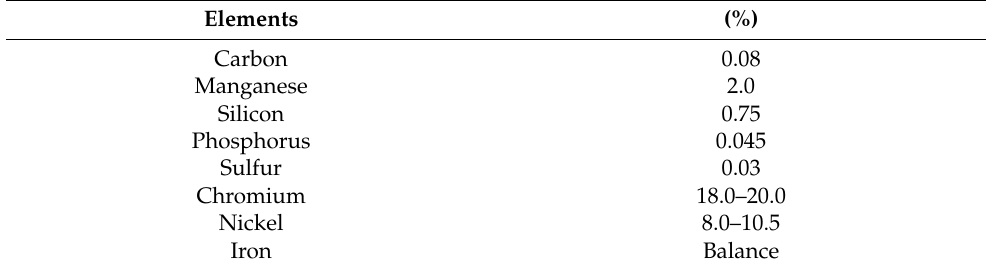
Table 1. Chemical composition of AISI 304 stainless steel sheets [20].